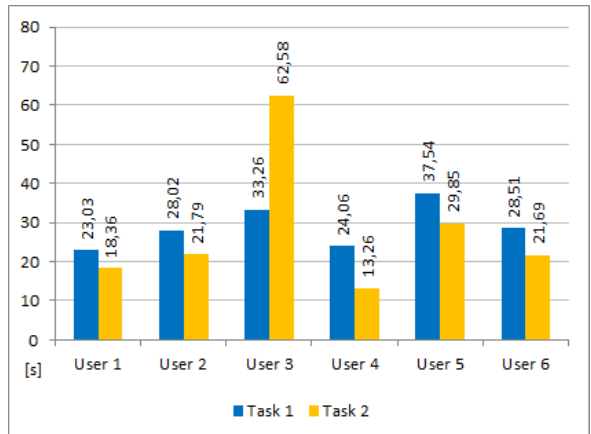
Fig. 3. The speed of task performance (in seconds) for individual users.